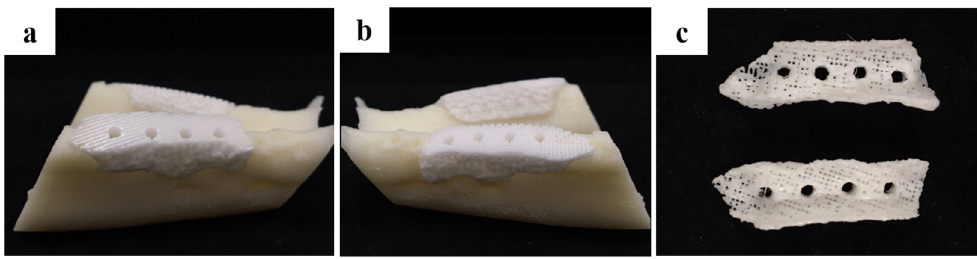
Figure 13. Photograph of a PCL/ β -TCP/bdECM scaffold used in the in vivo animal studies: ( a ) Right side view; ( b ) Left side view; ( c ) Inferior view.